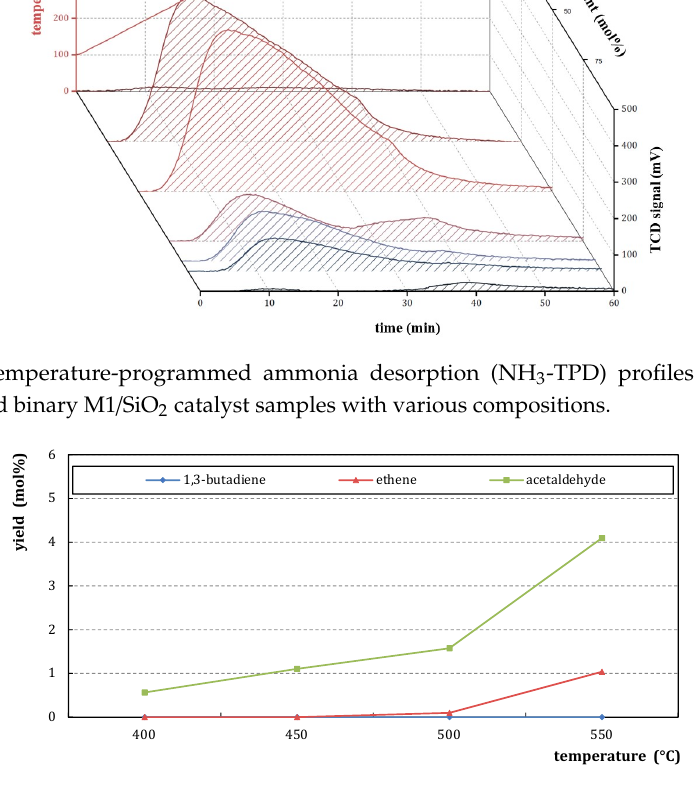
Figure A2. Results of the blank tests at different temperatures without catalyst sample in the reactor ( (cid:1865)(cid:4662) (cid:2889)(cid:2930)(cid:2899)(cid:2892) = 2.8 g/h; p = 5.5 bar(a); (cid:1848)(cid:4662) (cid:2898) (cid:3118) = 5 l/h). The yield Y of product i is calculated as follows: X · S i Y i = 100%.